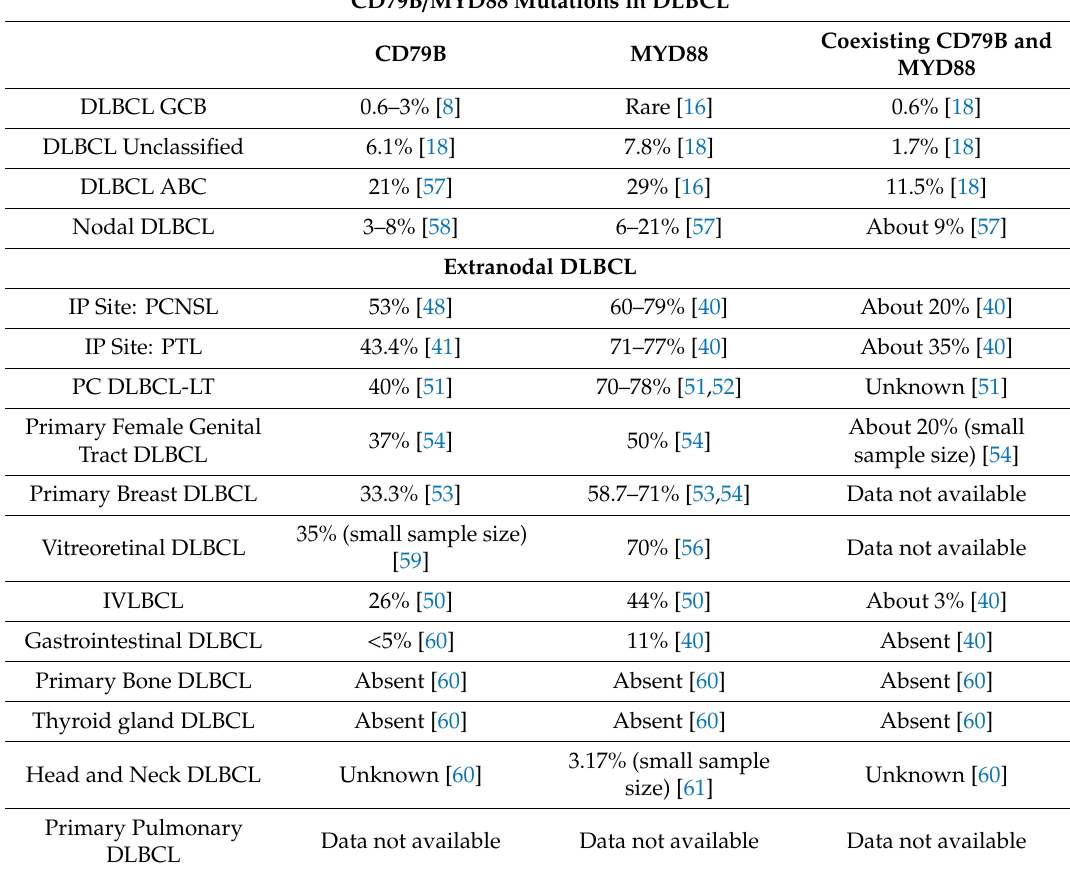
CD79B / MYD88 mutations in DLBCL. DLBCL: di ff use large B-cell lymphoma; GCB: germinal-center B-like; ABC: activated B-cell-like; IP: immune-privileged; PCNSL: primary central nervous system lymphoma; PTL: primary testicular lymphoma; IVLBCL: intravascular large B-cell lymphoma; PC DLBCL-LT: primary cutaneous DLBCL-Leg